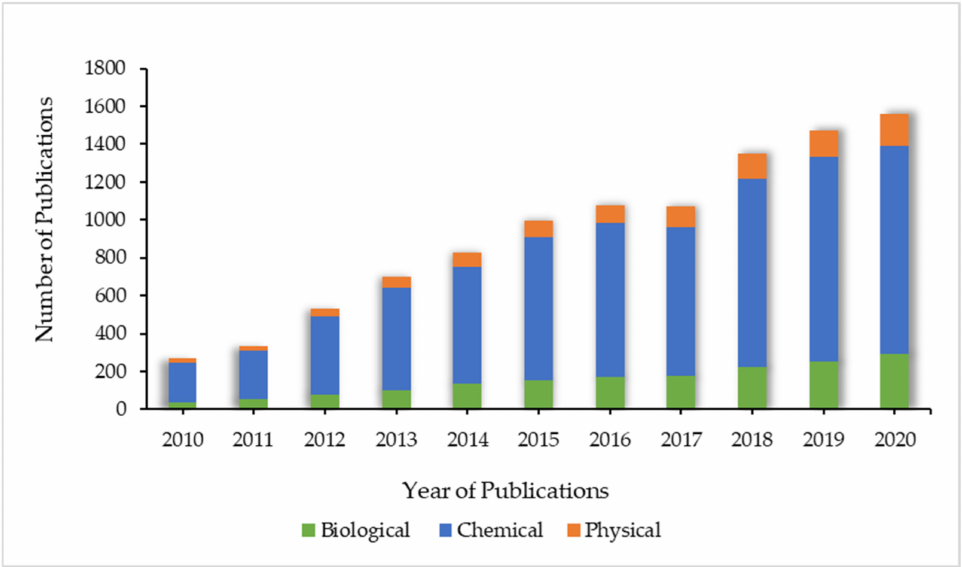
Figure 2. Annual numbers of publications relating to the search terms “Silver nanoparticles” and “Biological/Chemical/Physical” in the Scopus publication database between 2010 and 2020 (English language